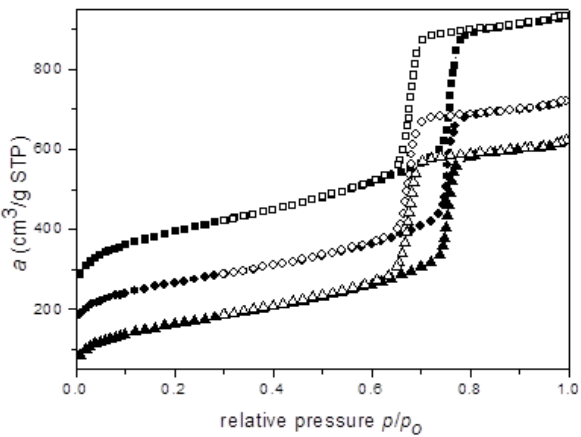
Figure 3. Nitrogen sorption isotherms of the parent SBA-15 (square), 4.4 / SBA-15 (circle), and 4.5 / SBA-15 (triangle). Adsorption branch filled, desorption branch open points. For clarity, 100 and 150 cm 3 / g (Standard Temperature and Pressure) was added to the isotherms of 4.5 / SBA-15 and SBA-15, respectively. Taken from Reference [42]- © Springer. Reproduced with the permission of Springer.